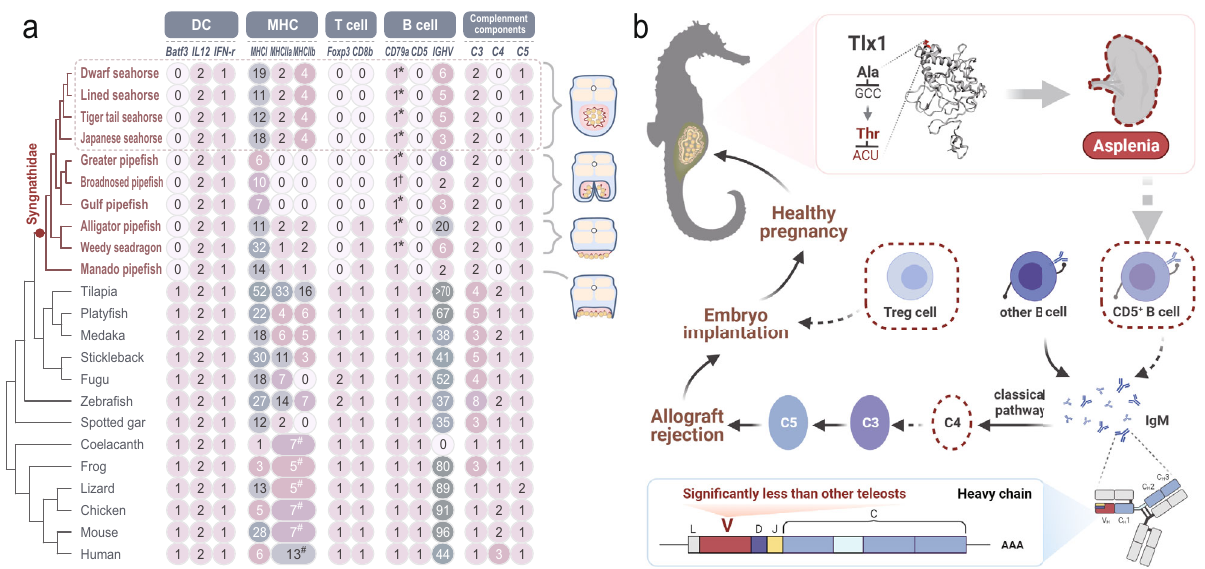
Fig. 4 | Immunogenomic basis of asplenia and male pregnancy in seahorses. a Copy numbers of key genes involved in the development and function of DC, MHC, T/B lymphocytes, and complement components 3 – 4 in seahorses and other vertebrates. DC dendritic cell, MHC major histocompatibility complex. *, variation of ITAM (immunoreceptor tyrosine-based activation motif) region; † , based on partialsequence(low-coveragesequencingandgenomeassemblies),butfeaturing thevariationofITAM;#,TotalnumberofMHCII.Thebroodpouchtypesareshown on the right. Hippocampus and Syngnathus species exhibit the closed brood pou- ches. b Schematic map illustrating the hypothesized molecular trade-offs in the